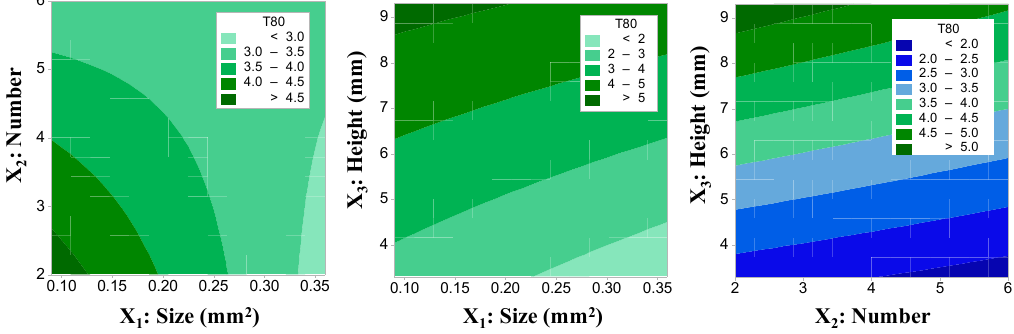
Figure 4. The effects of the control factors on T 80 of the gastroretentive sustained release drug delivery system in contour plots.